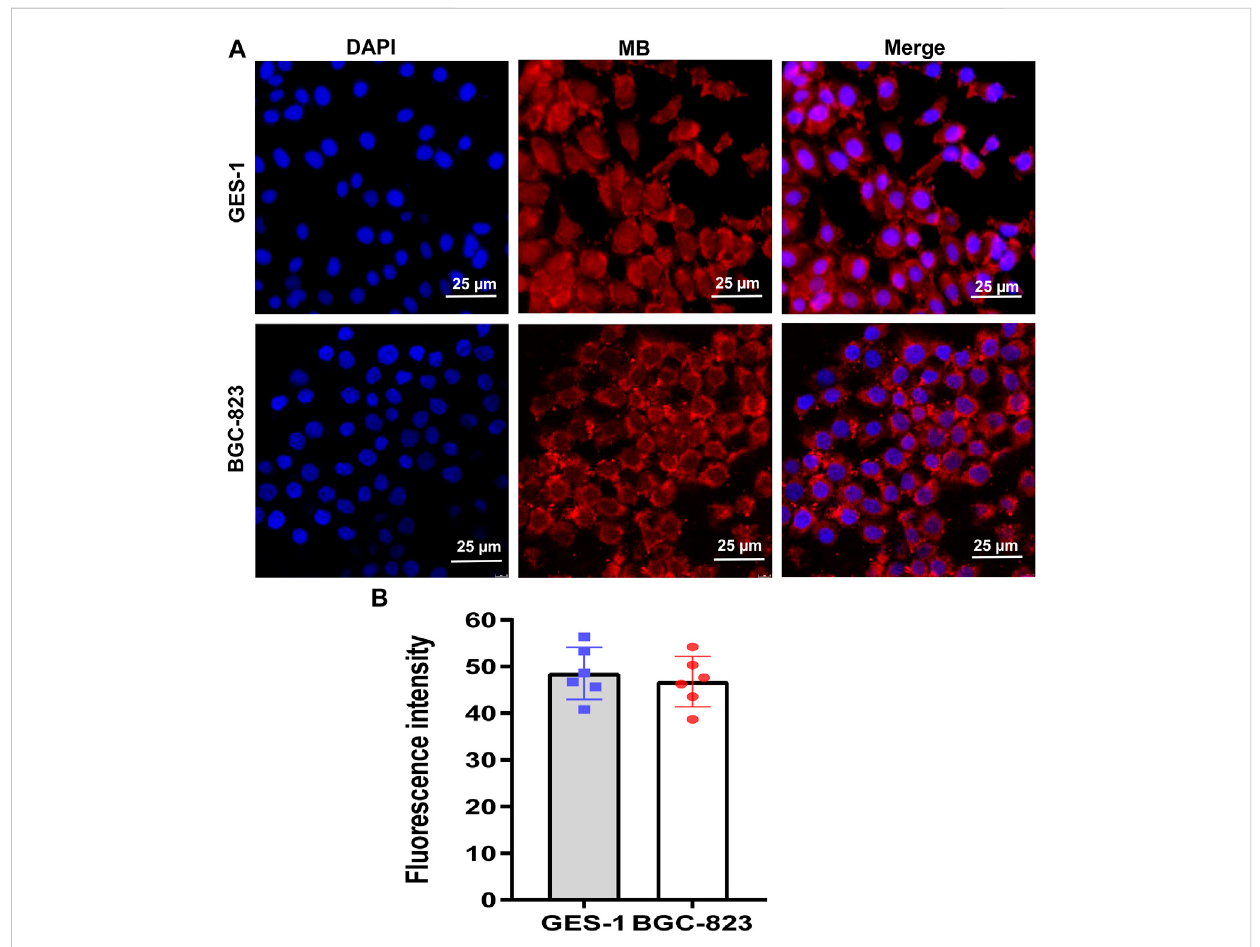
FIGURE 3 Fluorescence imaging of NIR fl uorophores MB in human gastric epithelial GES-1 cells and human gastric cancer BGC-823 cells. (A) Representative imageforDAPI(blue)andNIR(MB,red)inGES-1andBGC-823cellsundertheconfocal microscope. (B) FluorescenceintensityofMBinGES-1andBGC- 823 cells were analyzed by ImageJ. Scale bars = 25 μ m. Error bars show mean ±